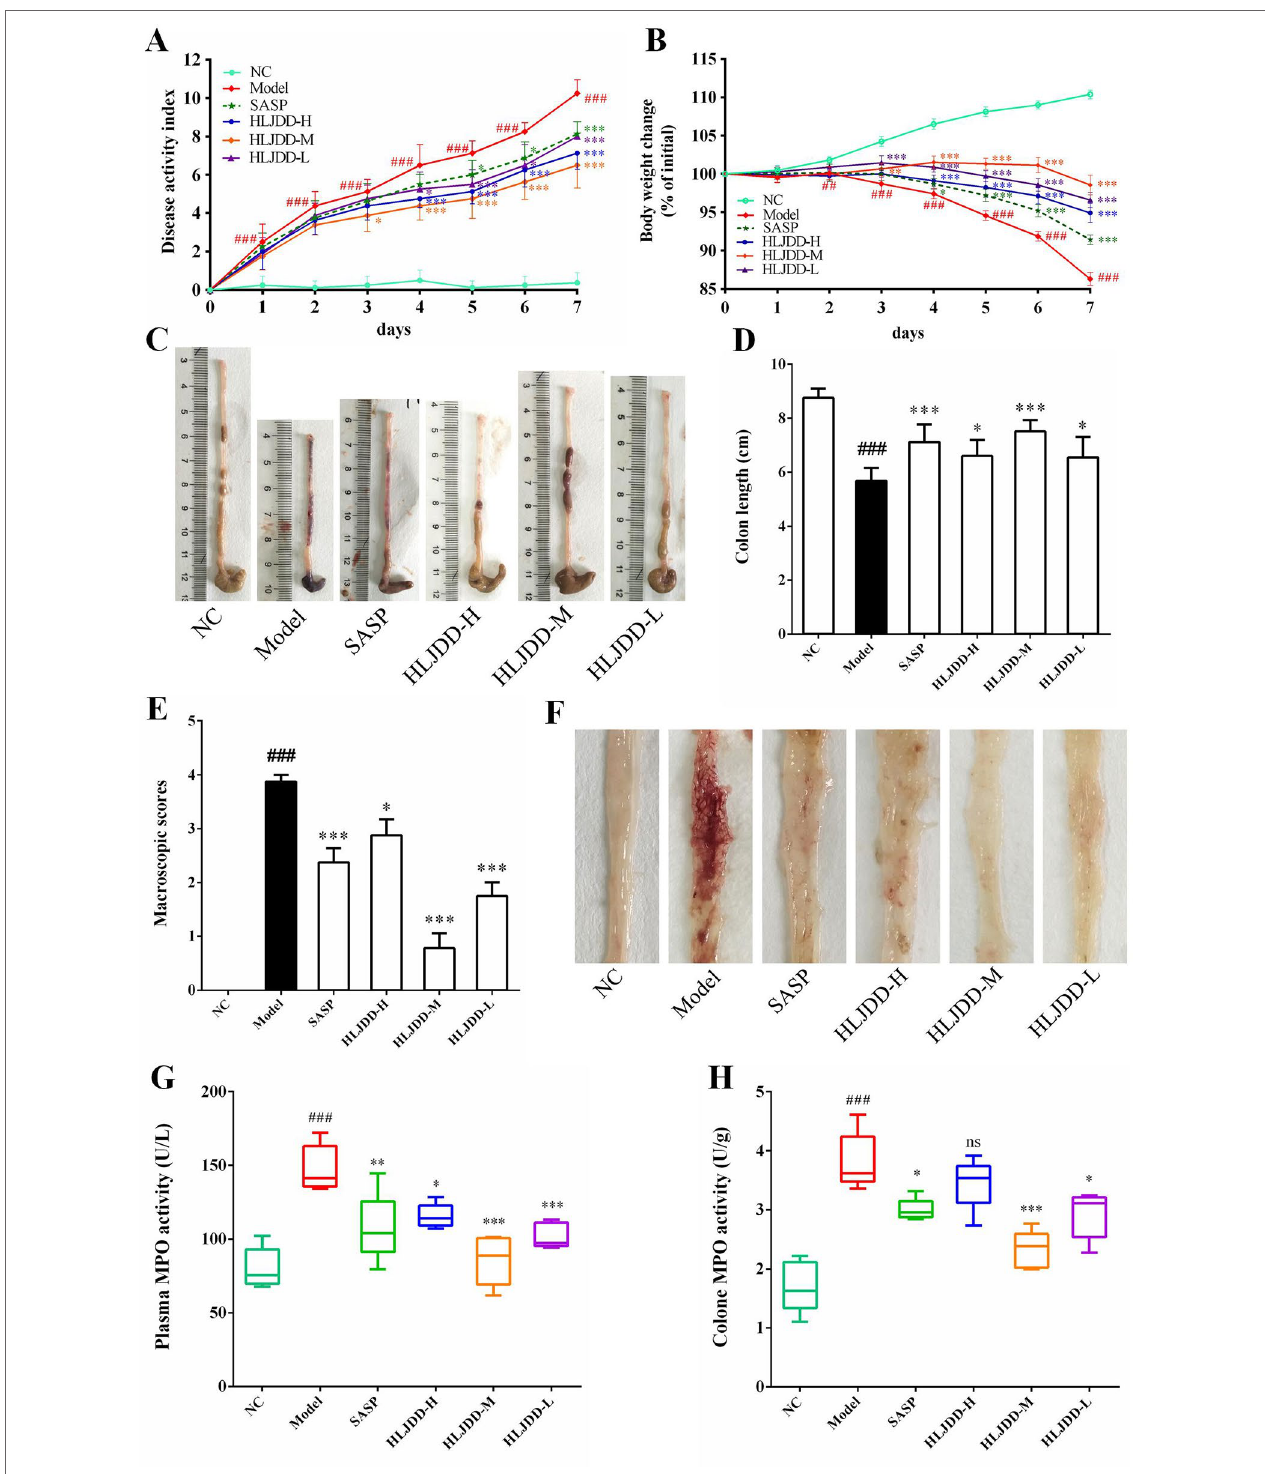
FIgURE 3 | HLJDD intervention relieves DSS-induced UC in mice. Disease activity index (A) and body weight change (B) of mice during experiment period. HLJDD alleviates DSS-caused colon length reduction (C , D) and intestinal injury (E , F) . HLJDD treatment reduces MPO activity in plasma (g) and colon tissues (H) of UC mice. Data are expressed as the mean ± SD, except for MPO activity analysis n = 5 per group, the remaining analysis n = 8 per group. ## p < 0.01, ### p < 0.001 vs. NC group; * p < 0.05, ** p < .01, *** < p 0.001 vs. model group. ns, no significant.